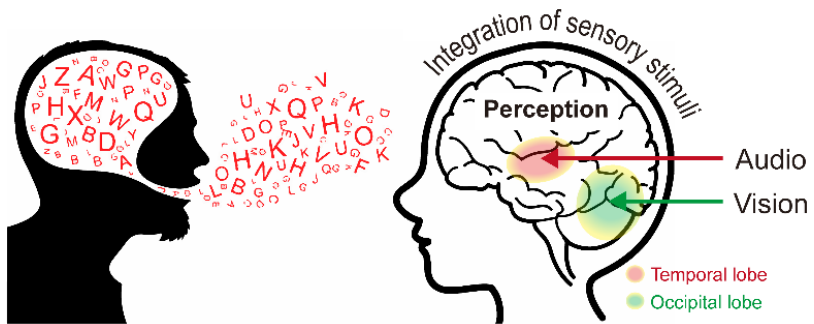
Figure 1. Multisensory integration comprising both auditory and visual information.